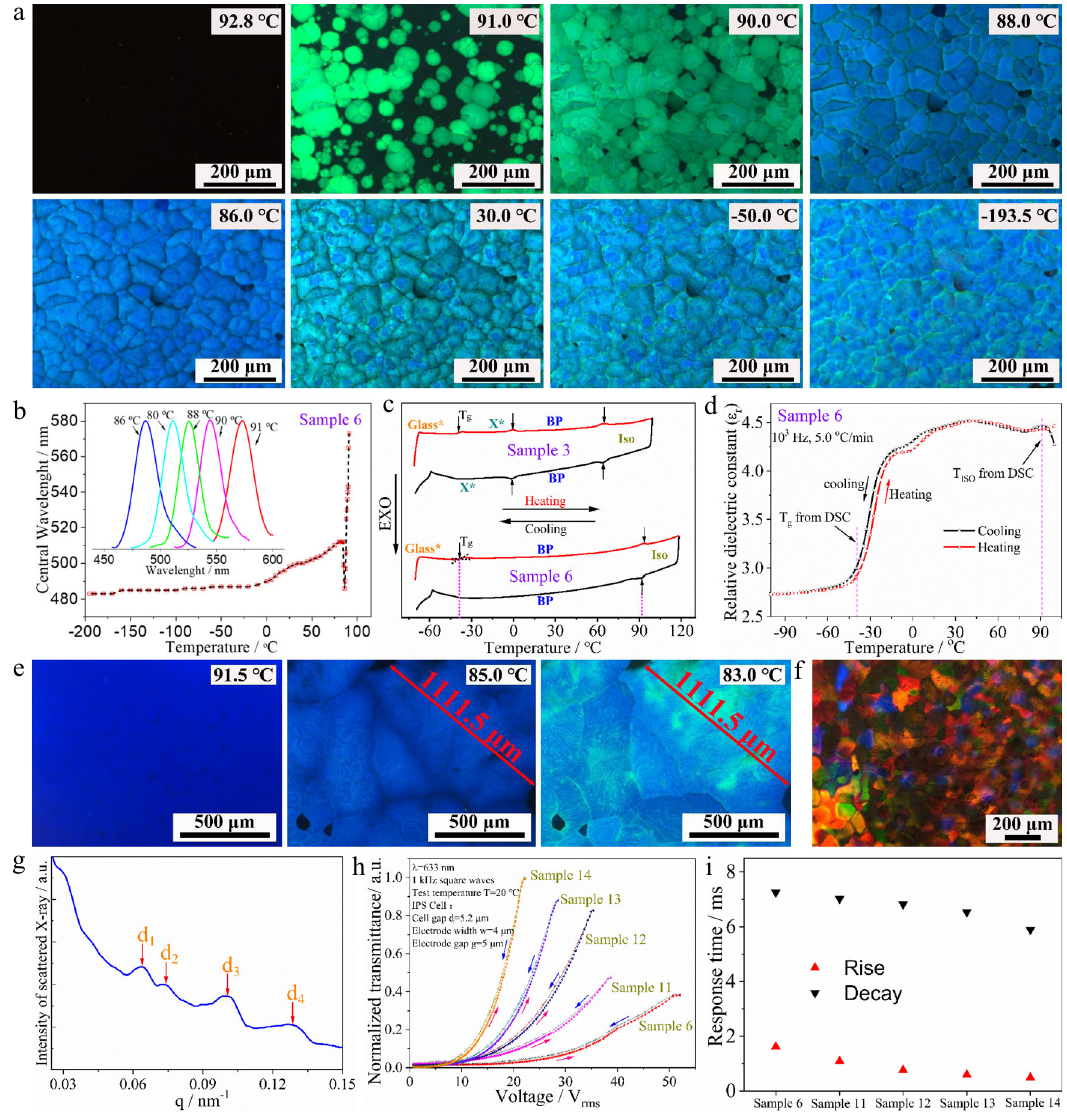
Fig. 2 Characterization of BPs using POM, fi ber optic spectrometer, DSC, impedance analysis, SAXS, and electro-optical testing. a POM textures of Sample 6 at different temperatures. b Temperature-dependent Bragg re fl ection of Sample 6. c DSC curves of Samples 3 and 6, phase transition points are marked via black arrows; corresponding temperatures are marked via red dashed lines. d Temperature dependence of relative dielectric constant ( ε r – T ) of Sample 6, corresponding phase transition points from DSC measurement are marked via red dashed lines. e Large BP single crystals obtained via thermal treatment. f POM textures of Sample 8 for SAXS measurement. g Intensity of scattered X-rays in arbitrary units as a function of the magnitude of the scattering vector q (an average value of three measures), corresponding scattered peaks of spacings d 1 – d 4 are marked via red arrows. h Voltage-dependent transmittance (V-T). i Electro-optical response curves of the BP